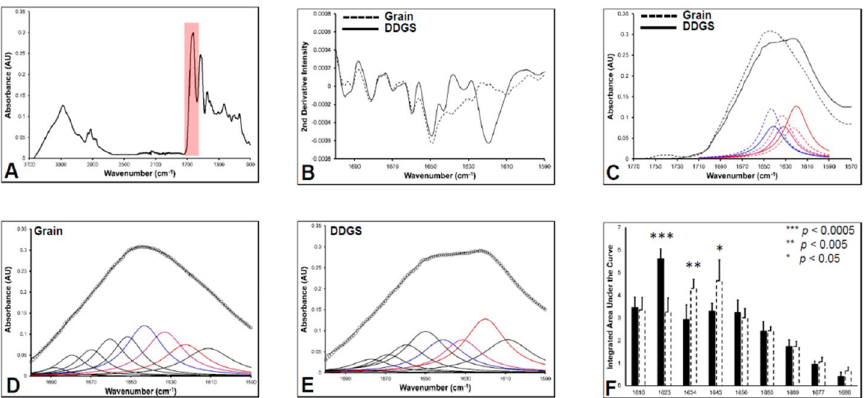
Figure 2. Attenuated total reflection-Fourier transform infra-red (ATR-FTIR) spectroscopics characterisation of protein secondary structure. ( A ) A representative spectra of the kafirin with the amide I band shaded in pink; ( B ) second-derivative spectra; ( C ) the representative overlay of fits centred at 1620, 1634, and 1643 cm −1 . DDGS kafirin is shown as solid red/pink/blue lines, grain kafirin shown as dashed red/pink/blue traces. ( D ) A representative complete fits for grain kafirin; ( E ) a representative complete fits for DDGS kafirin; ( F ) statistical analysis (n = 5 samples, students’ t test, 95% confidence interval) of examined